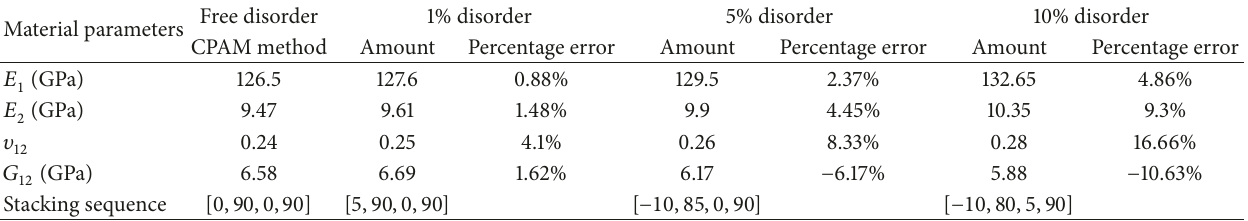
Table 11: Elastic constants determined for specimen C1 for different levels of disorder.